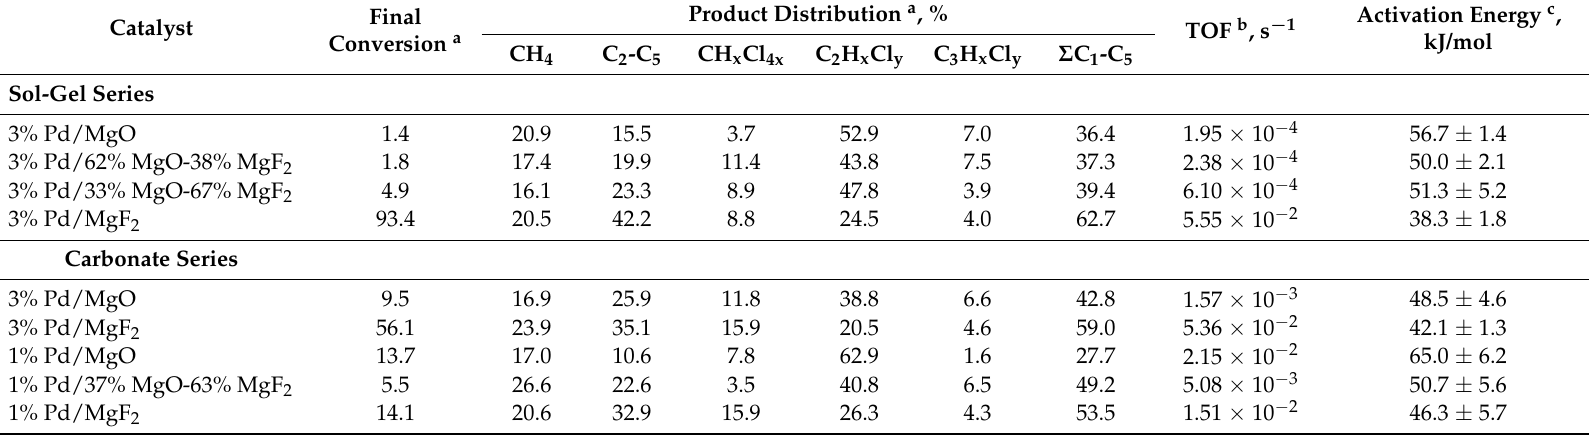
Table 3. CCl 4 hydrodechlorination on Pd/MgO-MgF 2 catalysts. Final conversions, product selectivities, TOFs and activation